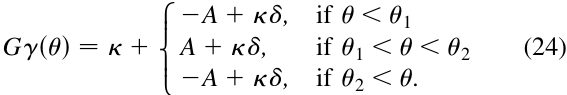
FIG. 3. (Color) Same as Fig. 2, except that (cid:3) jumps constructively interfere as the polarization makes 4 1 complete oscillations during the time between the two